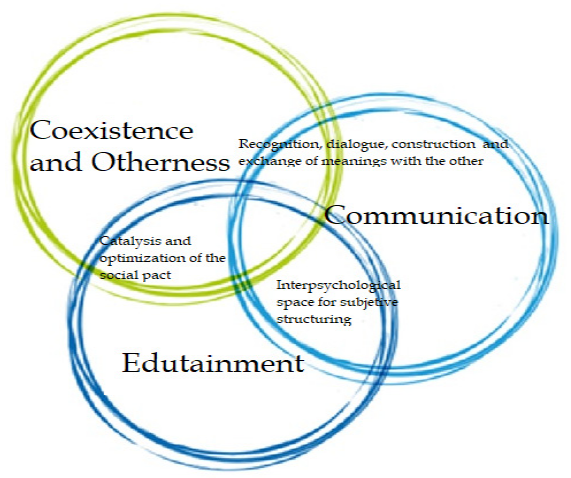
Figure 12. Fundamental elements. Source: Self-generated.